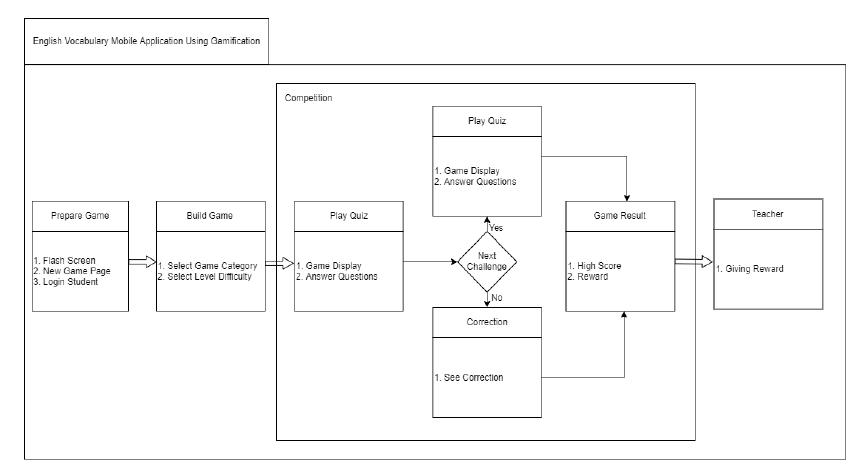
Fig. 1. Proposed Method